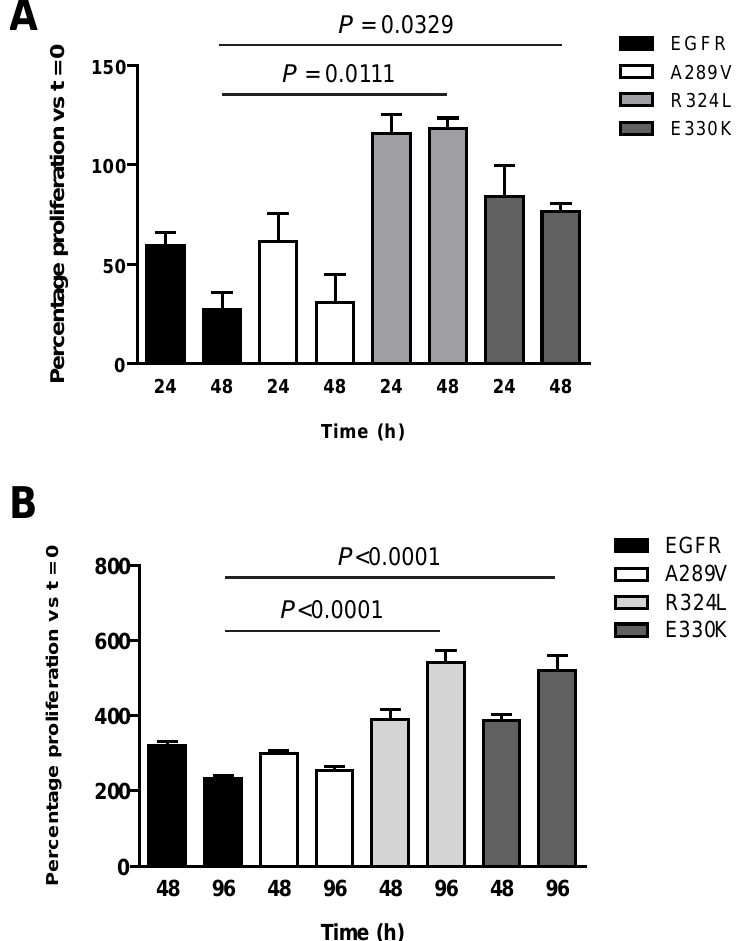
Figure 4. The R324L and E330K mutants show increased cell survival under serum free and 2% FBS conditions. Transgenic cells were cultured under ( A ) serum free conditions for 48 h and ( B ) in media containing 2% FBS for 96 h. Cells were tested for proliferation at various time points using the MTS assay. The data shown is the percentage of cell growth at each time point compared to the 0 h control ±